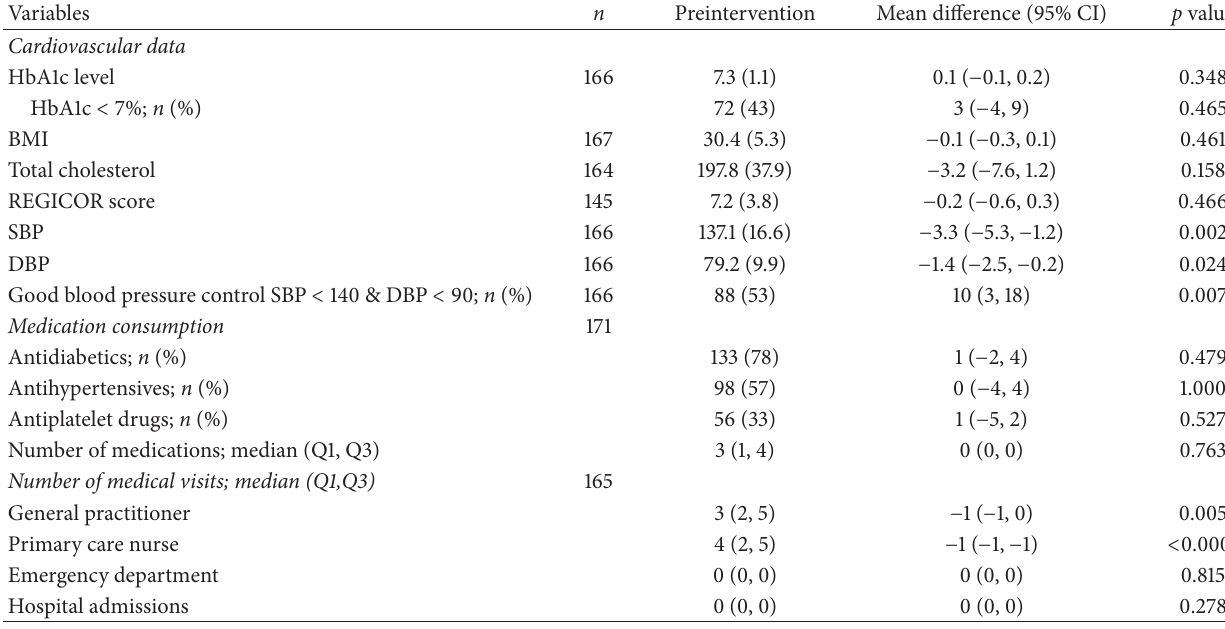
Table 2: Cardiovascular clinical variables and number of medical visits and times of hospitalization at baseline and 6 months after the intervention